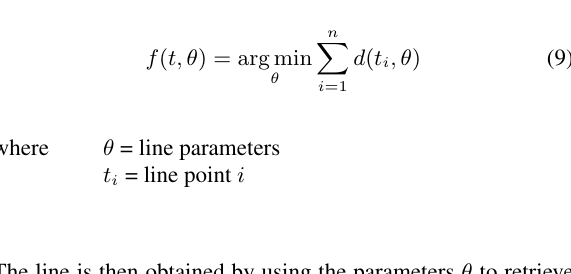
fitting algorithm is proposed. Most line fitting methods minim- ise the point to line distance d for any given point on the line using Equation 9.